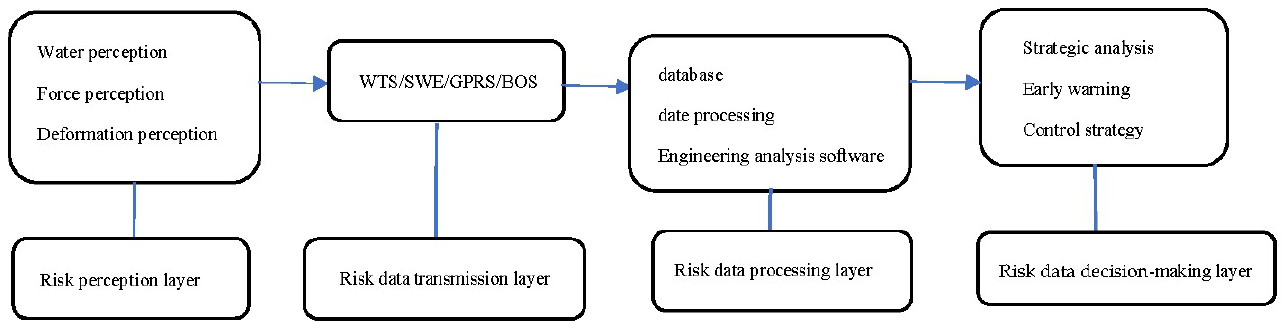
Figure 7. 5S-based data transmission flow chart.